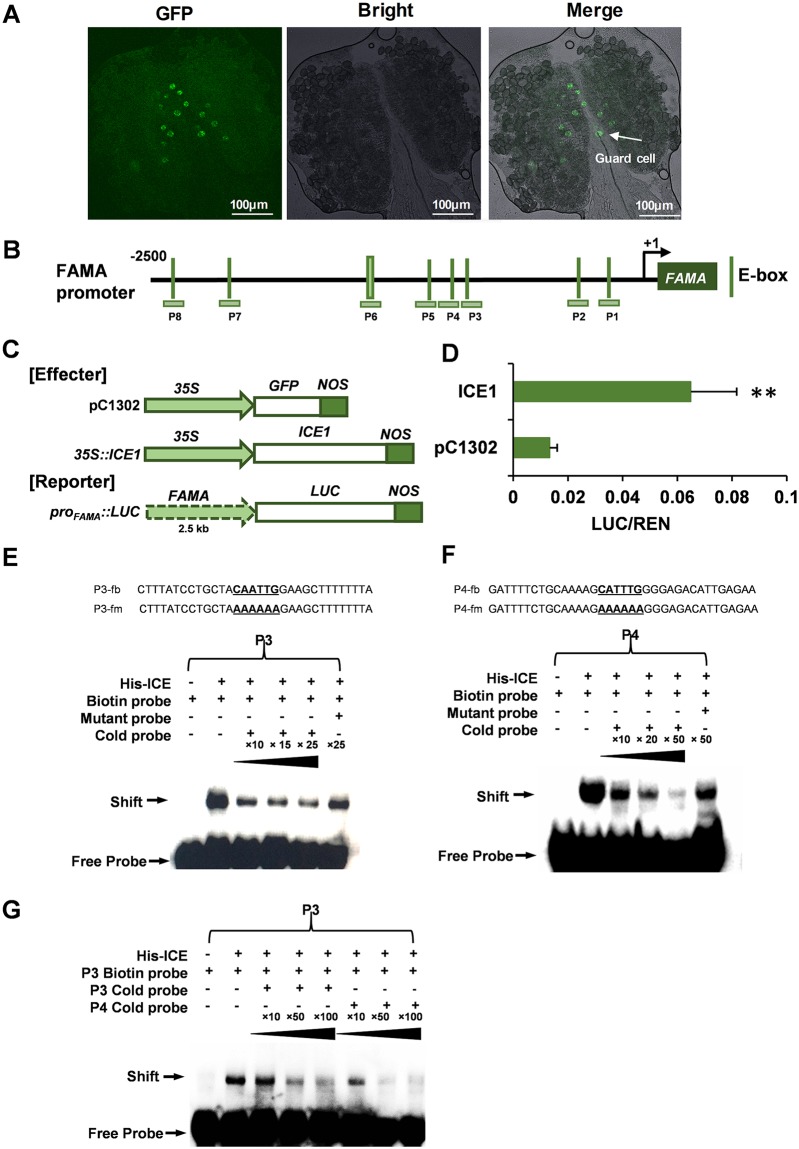
ICE1 directly binds to the promoter of FAMA to activate its expression.(A) Confocal images of FAMA protein accumulation (indicated by arrows) in the anther at flower stage 12 in FAMApro::FAMA-GFP plants. (B) The upstream region of 2.5 kb from transcription start site and ORF sequences of FAMA are shown with a black line and a blackish green box, respectively. The vertical lines indicate the E-box positions. Eight probes (P1 to P8) containing E-boxes are also exhibited. P6 contains two E-boxes. (C) Dual-LUC Assays in tobacco leaves. ICE1 driven by 35S promoter was served as the effector and LUC under control of FAMA promoter (2.5 kb upstream from transcription start site) was the reporter. (D) The relative activity (LUC/REN) is shown. The reporter co-transformed with pC1302 vector was used as the control. SE, n = 6, ** p < 0.01. (E-F) Electrophoretic mobility shift assay (EMSA) showing the binding activity of ICE1 to the probes with E-box elements at -582 to -613 bp (labeled as P3 in B) and -629 to -664 bp (labeled as P4 in B) upstream from transcription start site of FAMA, respectively. The sequences of P3 and P4 as well as mutated probes are listed. (G) EMSA showing the competition of ICE1-P3 interaction using P4. P4 has higher binding affinity with ICE1 than P3.